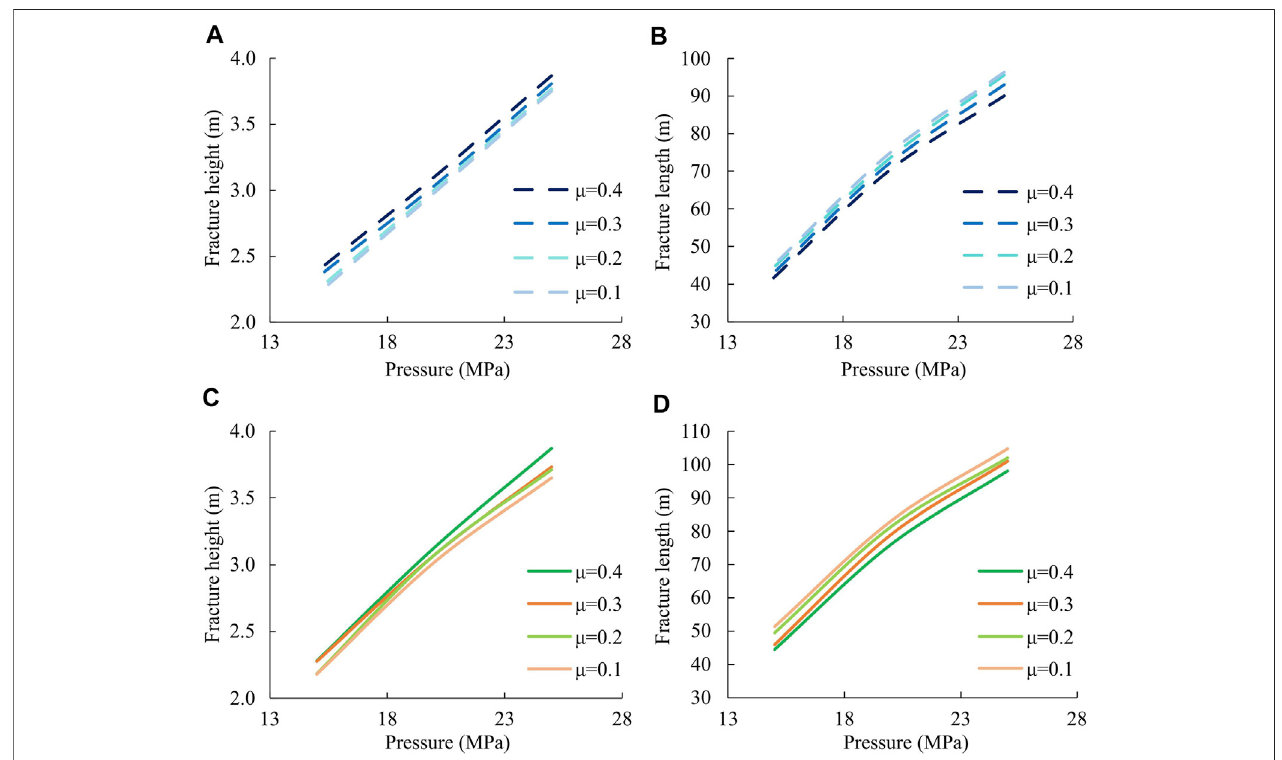
FIGURE 11 | Fracture parameters under different Poisson ’ s ratio of the roof and fl oor (A) The fracture height of the No. 9 coal seam. (B) The fracture length of the No. 9 coal seam. (C) The fracture height of the No. 13 coal seam. (D) The fracture length of the No. 13 coal seam.